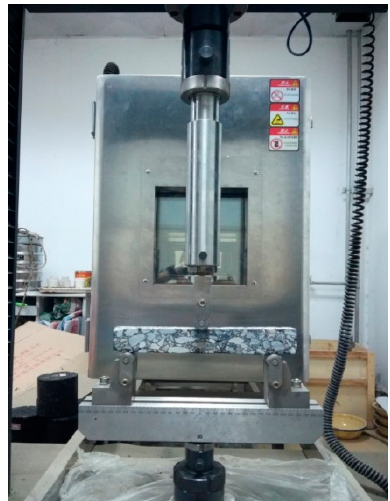
Figure 8. Low temperature bending test process.